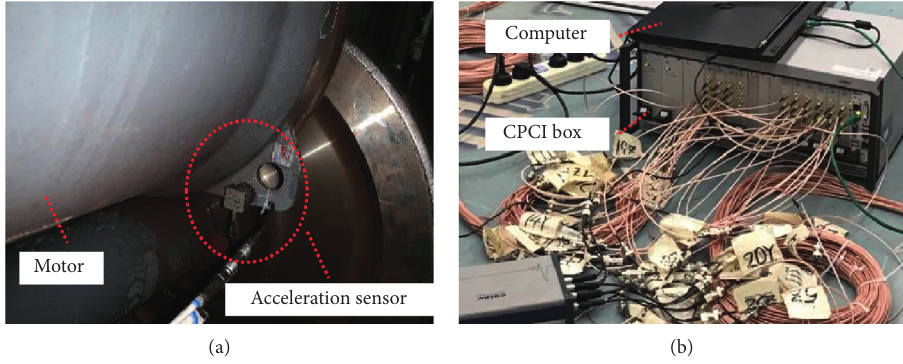
Figure 6: (a) Motor test point. (b) CPCI box and computer.